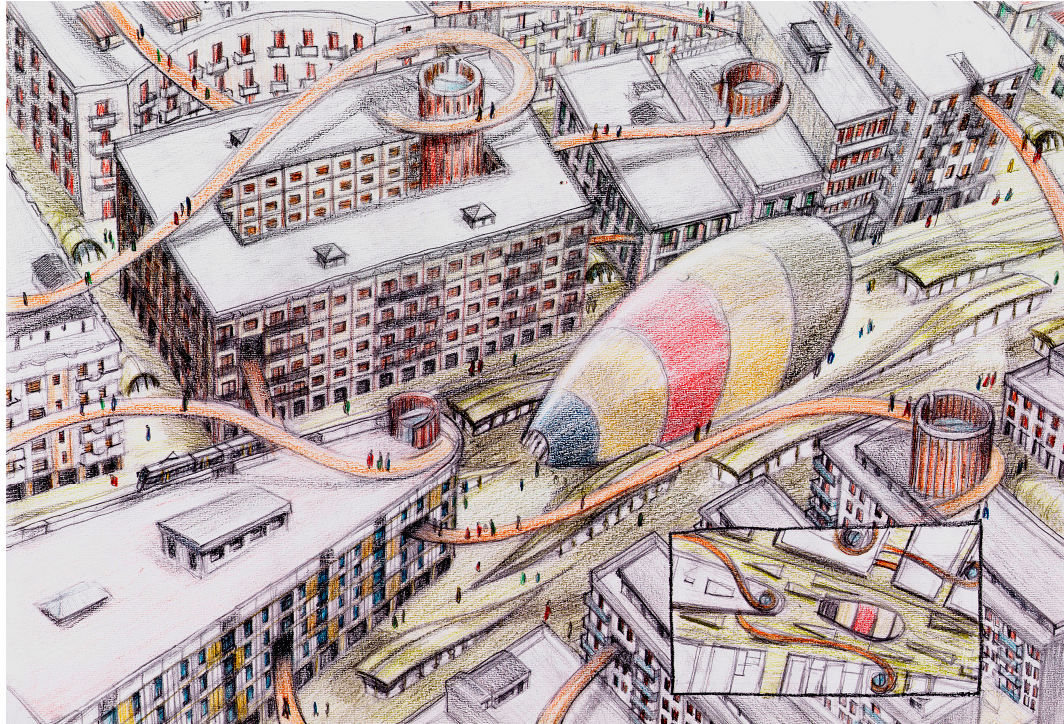
Figure 9. Michela De Domenico, Città